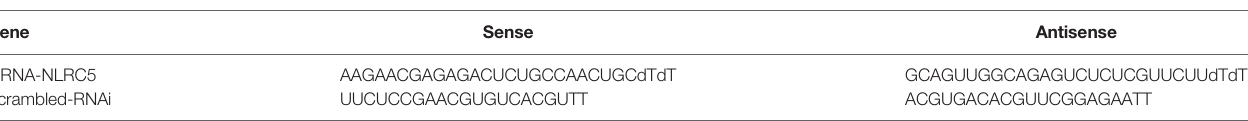
TABLE 3 | siRNA-NLRC5 and scrambled-RNAi plasmid sequences. Gene